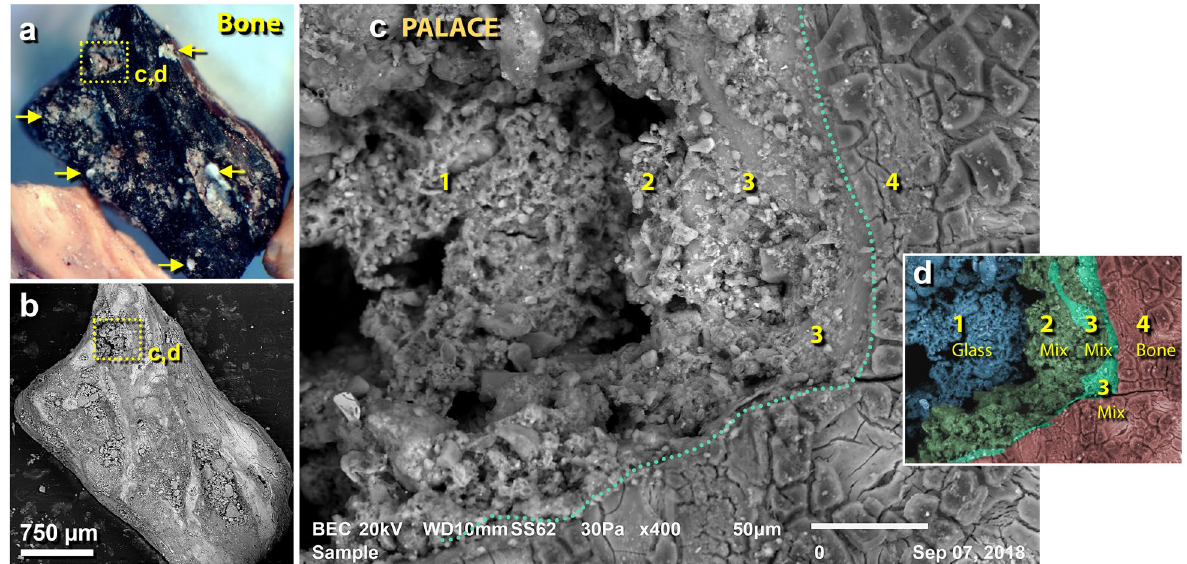
Figure 45. Bone fragment splattered with meltglass in the destruction layer. ( a ) Photomicrograph of 3.5-mm-long charred bone from the palace. The yellow boxed area indicates an area of melted glass on bone, as shown in panels ‘ c ’ and ‘ d ’. Yellow arrows point to other areas with greenish meltglass fused to the bone. ( b ) SEM image of bone in panel ‘ a ’. ( c ) SEM close-up image of boxed area in panel ‘ a ’. Green dotted line marks the glass-to-bone boundary, as further shown in panel ‘ d ’. #1 represents unmelted Ca–Al–Si-rich sediment with no bone component; #2–3 represent partially melted sediment mixed with melted bone (hydroxyapatite); #4 presents charred bone. ( d ) Colorized SEM image of panel ‘ c ’ showing gradation of bone-and-sediment mixing, based on multiple SEM–EDS